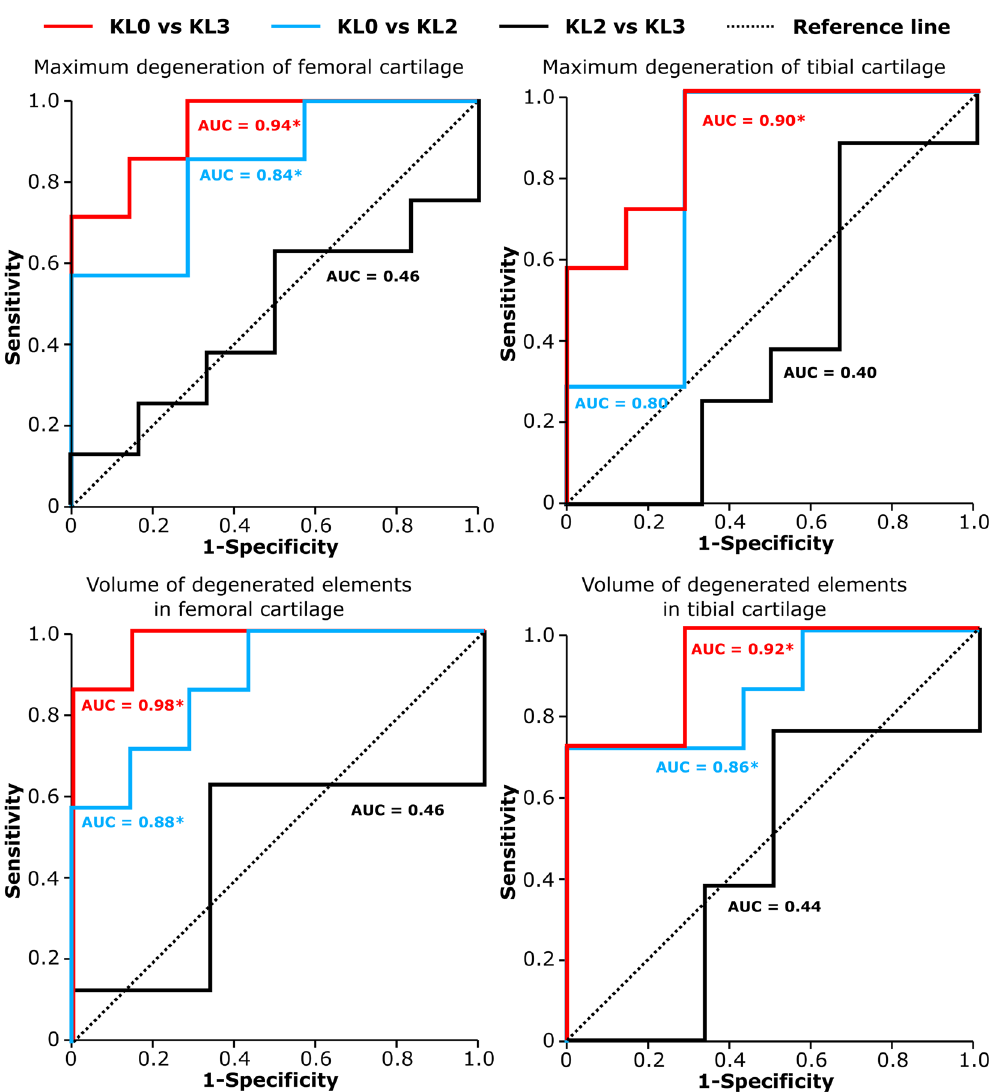
Figure 6. Receiving Operating Characteristics (ROC)-curves and Area Under Curve (AUC)–values (see statistical analysis in the Methods section) for the maximum degeneration and volume of degenerated elements of femoral and tibial cartilage. * p <